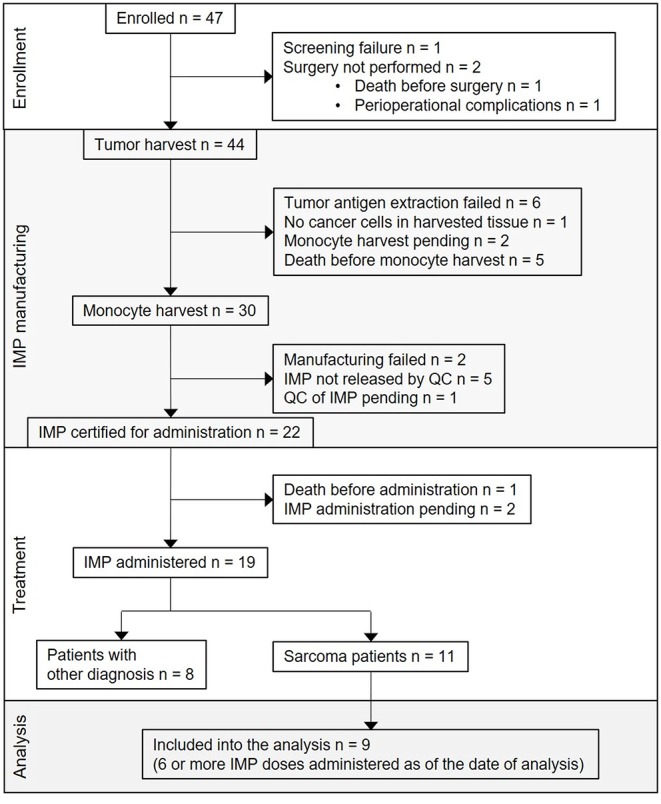
Flow diagram for DC-based immunotherapy trial and study group definition. CONSORT flow diagram showing participant flow through each stage of the trial [enrollment, DC-based investigational medicinal product (IMP) manufacturing, treatment] and the analysis of sarcoma patients study group.